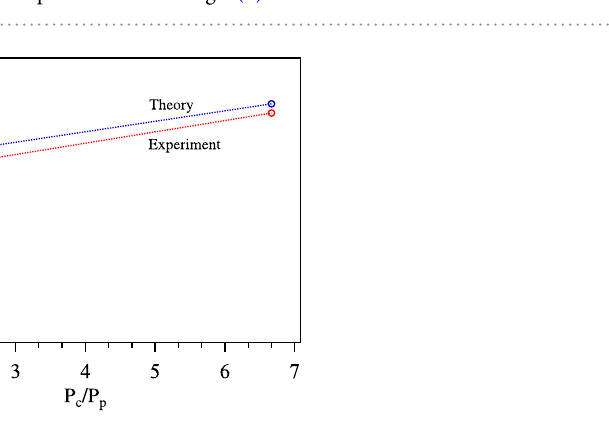
Figure 7. Amplitude of the resonance (as defined in the text) as a function of control ellipticity for 4 values of control power. The probe power is fixed at 30 μ W, and the values of control power are given in terms of power ratios. Part (a) shows the experimental results while part (b) shows the theoretical results. Note that the ratio of Rabi frequencies is equal to the square root of the powers. The experimental points have 1 σ error bars obtained from the fit, but are not seen because they are smaller than the symbol. Theoretical points are obtained from simulations using the same parameters as in Fig. 6(b).